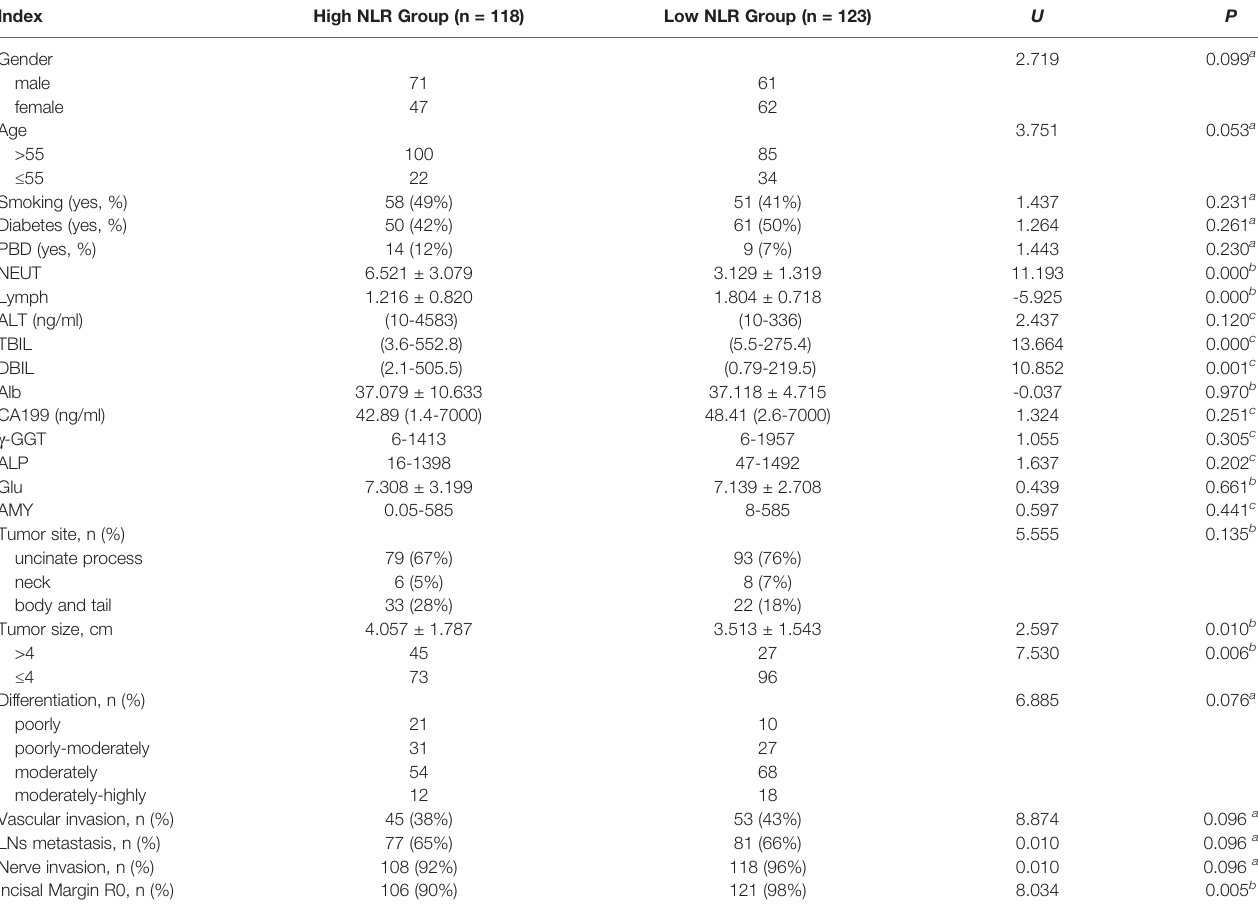
TABLE 1 | Background data preoperative and pathological results in various NLR